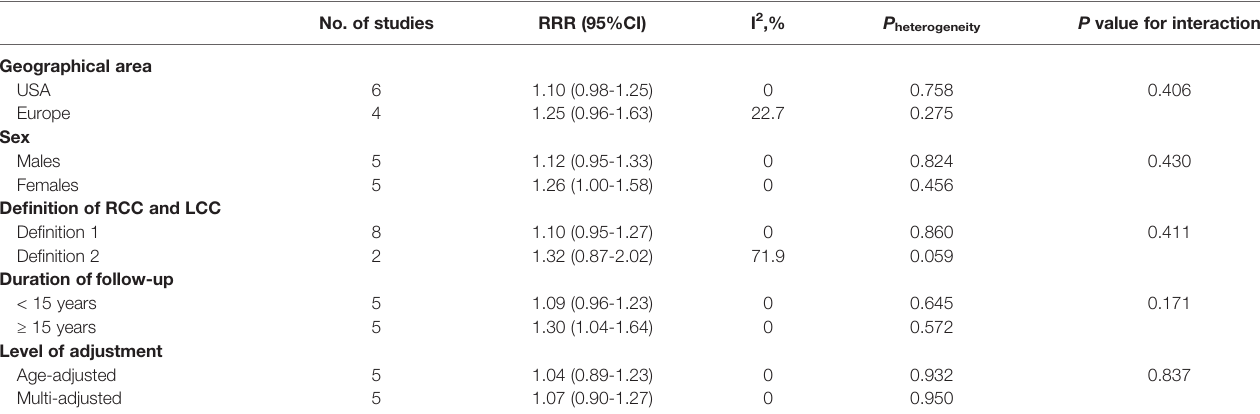
TABLE 3 | RCC-to-LCC ratio of relative risks (RRRs) and 95% con fi dence intervals (CIs) for sensitivity analysis. No. of studies RRR (95%CI) I 2 ,% P heterogeneity P value for